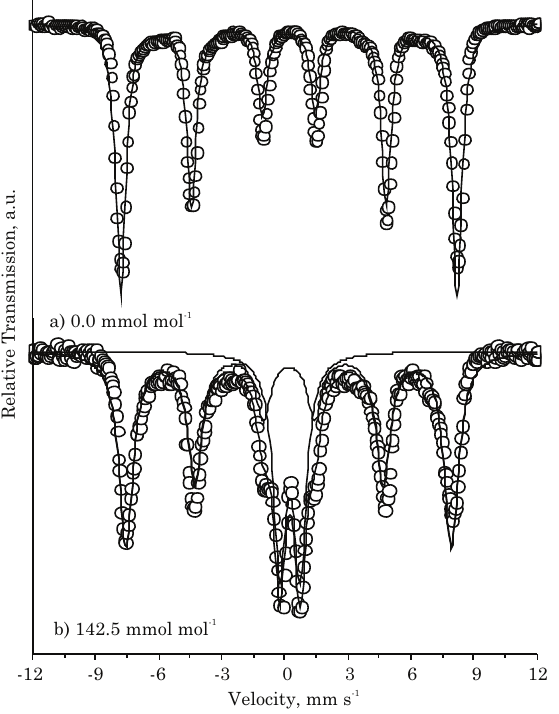
Figure 3. RT Mössbauer spectra for pure maghemite (a) and with 142.5 mmol mol -1 (b) of isomorphic substitution of Fe 3+ for Al 3+